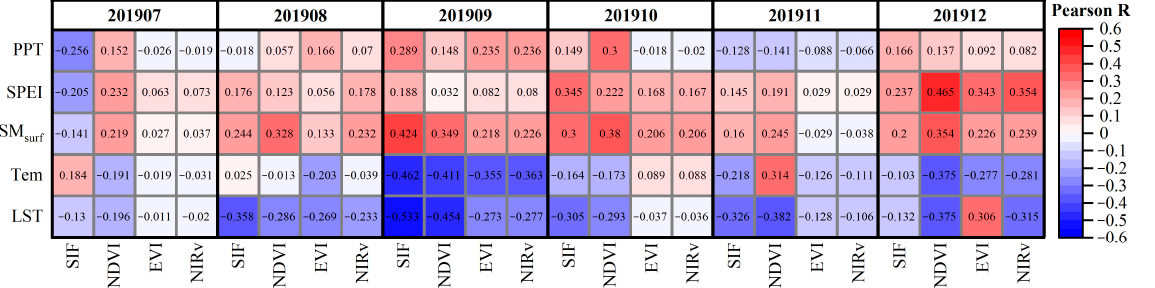
Figure 14. Pearson correlation coefficients between the standardized anomalies of drought indices and that of SIF as well as VIs during July–December 2019. and that of SIF as well as VIs during July–December